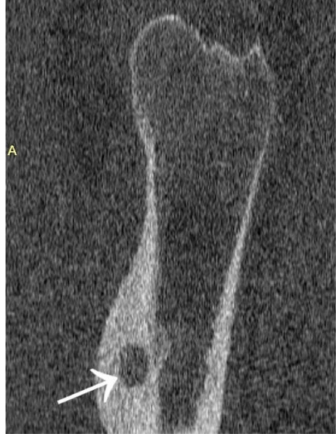
Figure 19. CT scan showing a focus of OO (arrow) in the left lesser